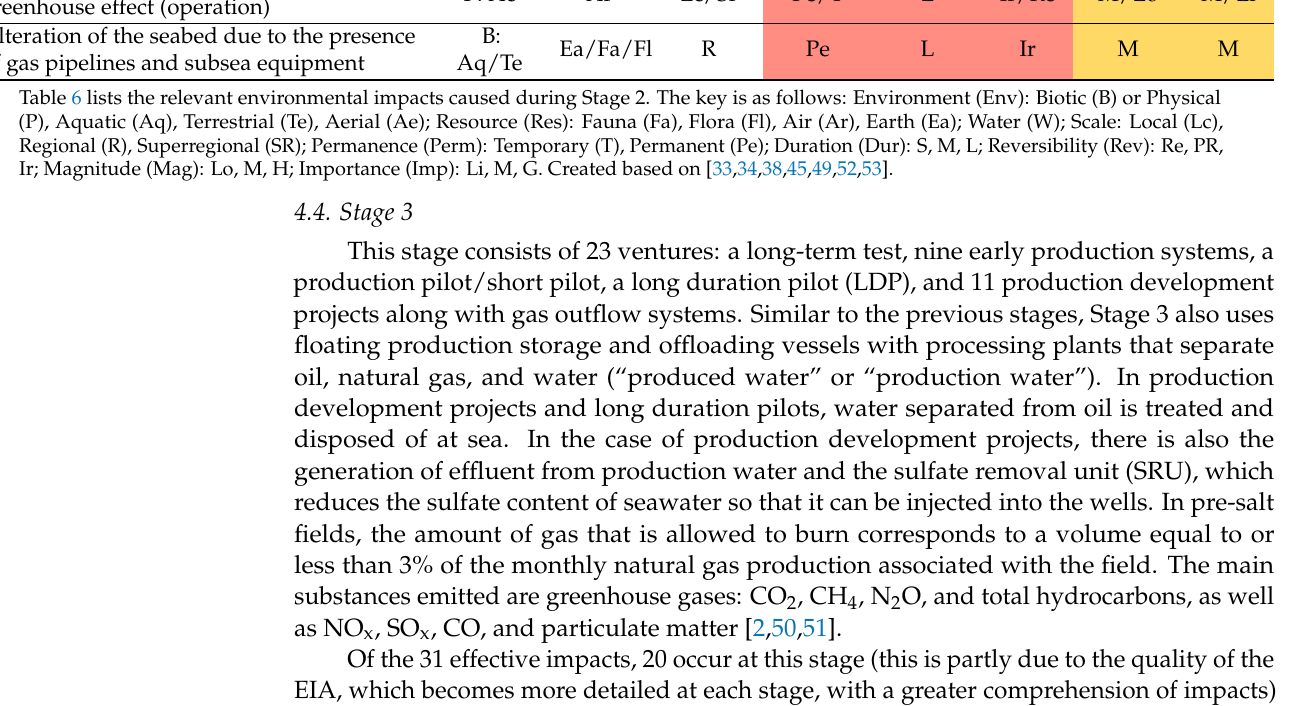
Table 6. Effective impacts during Stage 2.